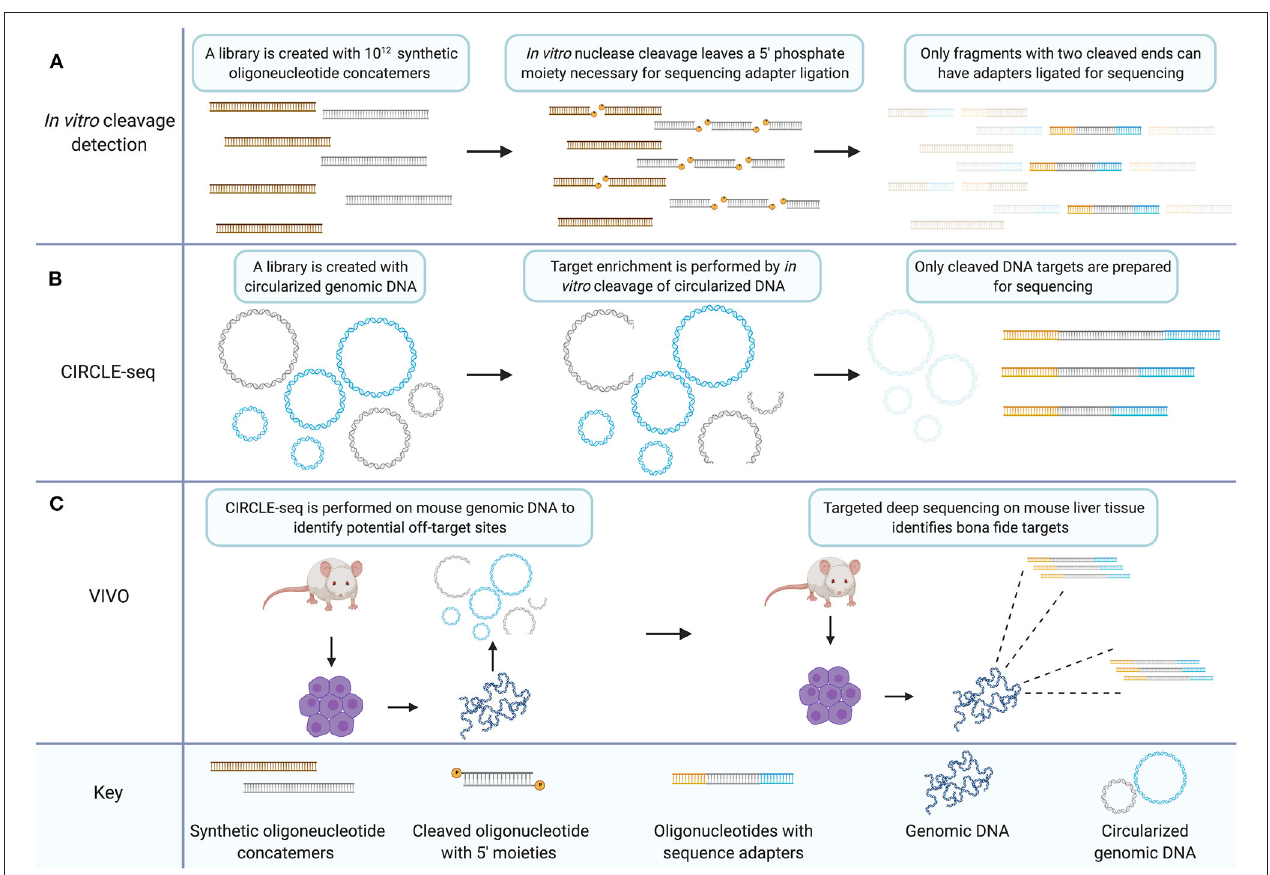
FIGURE 2 | The CIRCLE-seq target enrichment strategy creates an in vitro library of CRISPR/Cas9 targets with biological relevance that can inform targeted sequencing for validation of bona fide off-target sites. (A) In vitro cleavage detection involves generating a library of synthetic oligonucleotide concatemers with potential mismatch targets for a CRISPR gRNA. Target cleavage leaves a 5 ′ phosphate necessary for ligation of sequencing adapters. Only fragments which have been cleaved at both ends because the target site within the concatemer was recognized by the nuclease two times, are prepared for sequencing. (B) CIRCLE-seq involves generation of a circularized in vitro library created from genomic DNA. Unrecognized targets remain circularized (in blue) while cleaved target sequences are linearized and can be prepared for sequencing (in gray). (C) VIVO involves performing CIRCLE-seq with genomic DNA from mouse primary cells. The CIRCLE-seq results inform targeted deep sequencing with genomic DNA from mouse primary cells derived from CRISPR/Cas9 treated mice thereby validating bona fide off-target sites. Created with